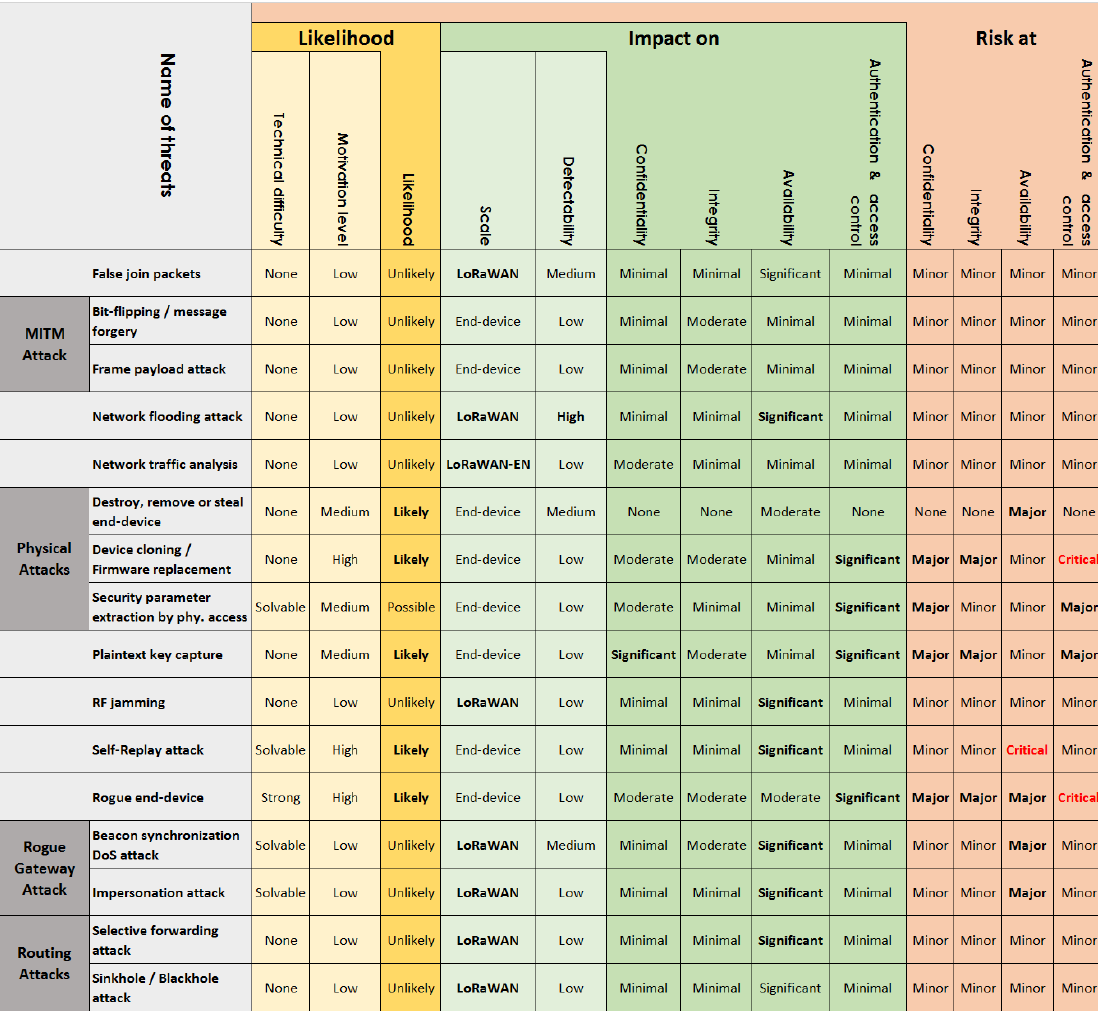
Figure 6. Likelihood, impact and risk of attacks against LoRaWAN